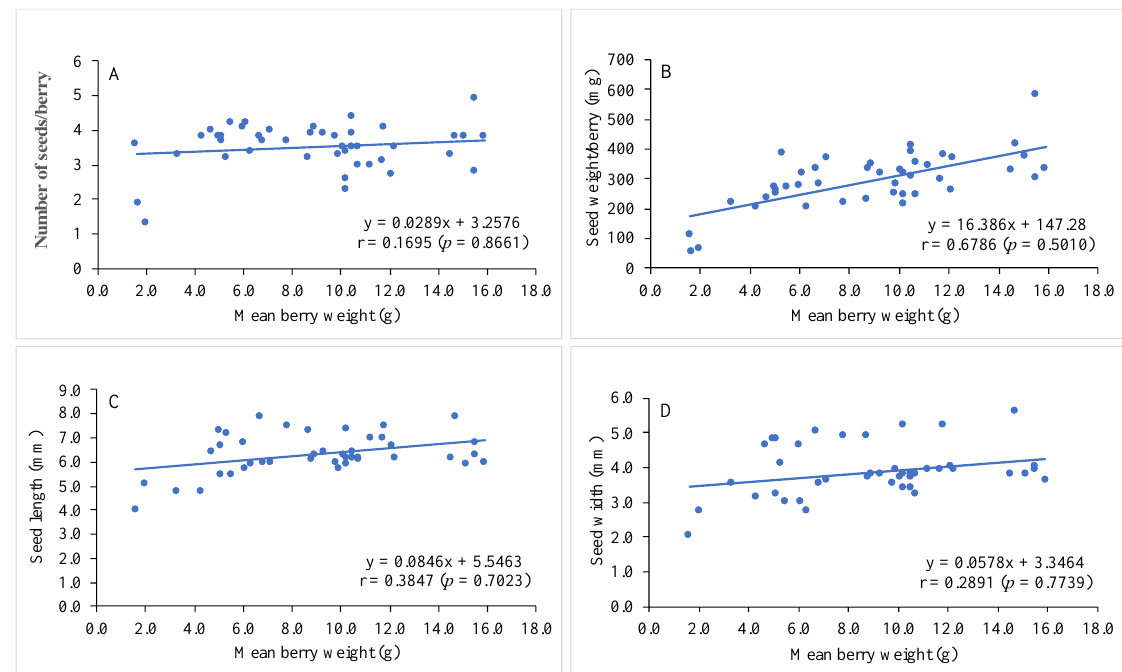
Figure 1. Scatter plots showing relationship between mean berry weight and ( A ) number of seeds/berry, ( B ) seed weight/berry; ( C ) seed length, and ( D ) seed width of muscadine and bunch grape cultivars. r = coefficient of correlation and p = significance level.